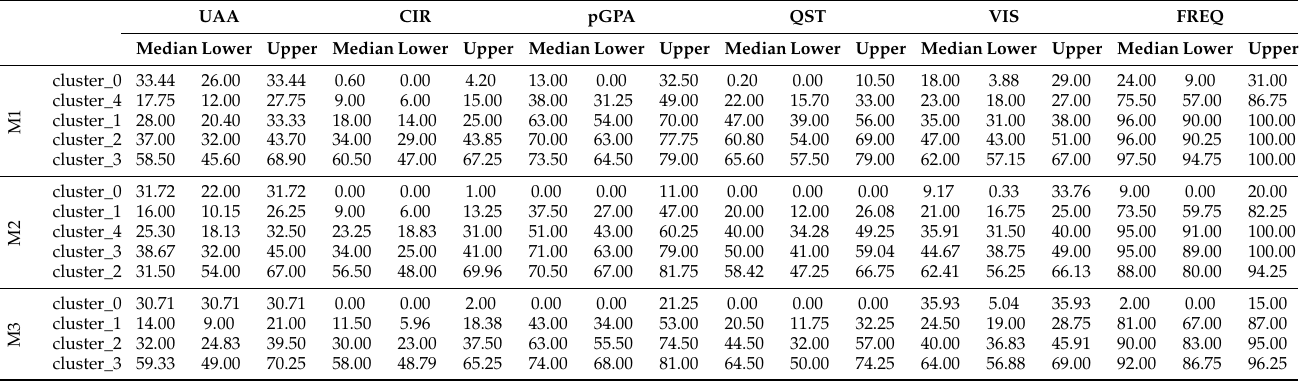
Figure 9. Clustering at M3. Table 6. Median, lower quartile, the upper quartile of clusters by attributes at M1, M2, M3. UAA CIR pGPA QST VIS